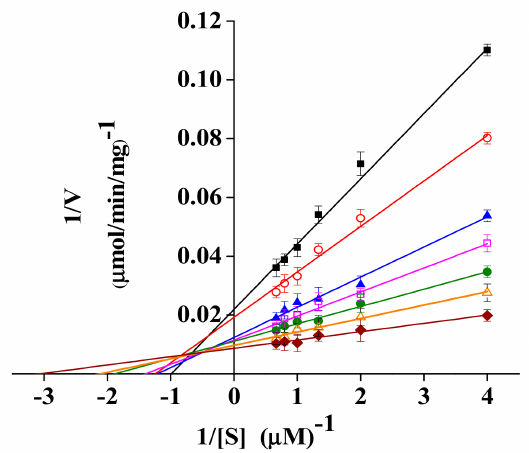
Figure 6. Lineweaver–Burk double reciprocal plots of purified RNase R with respect to yeast RNA at 0 ◦ C ( (cid:4) ), 5 ◦ C ( ), 10 ◦ C ( (cid:78) ), 15 ◦ C ( (cid:3) ), 20 ◦ C ( (cid:8) ), 25 ◦ C ( (cid:52) ), and 30 ◦ C ( (cid:117) ). Activity was measured as (cid:35) above described. Every experiment was done in